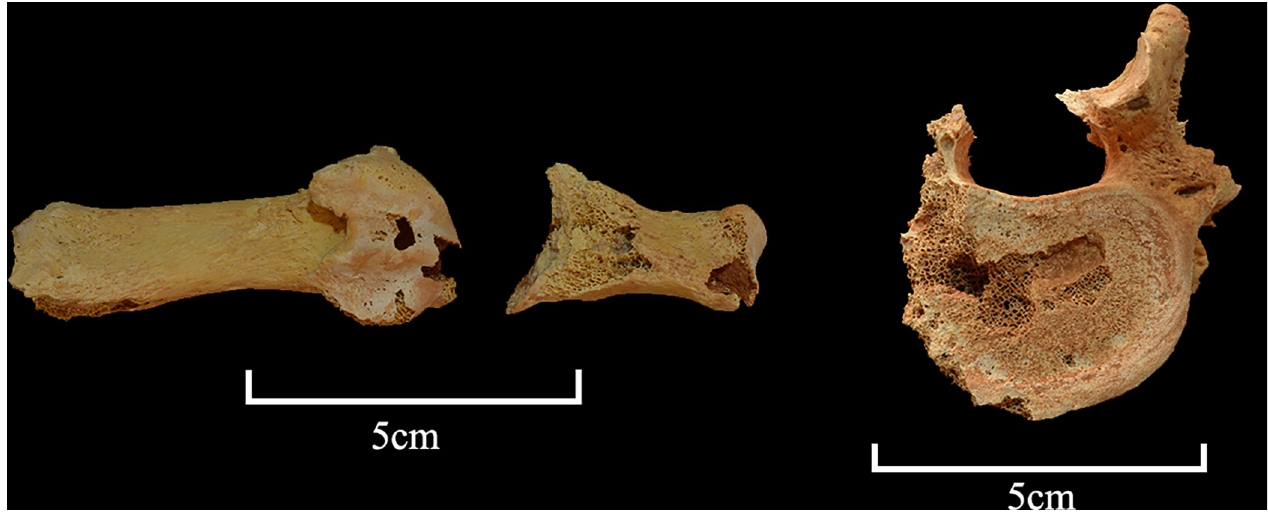
Fig 24. Detail of human bones marked by osteoarthritis.